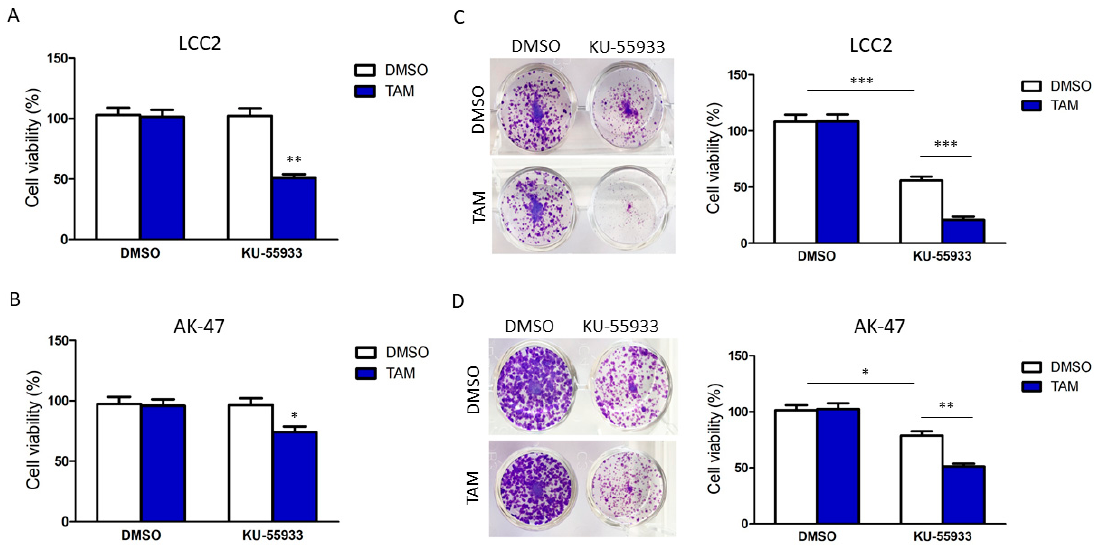
Figure 4. The effect of ATM inhibition by KU-55933 on TAM resistance and cell viability. The short- term effect of KU-55933 on TAM response in ( A ) LCC2 and ( B ) AK-47. The cells were treated with 5 nM of KU-55933 and 4 µ M of TAM for 96 h. Cell viability was determined by MTT assay. Student’s t -test was employed to compare the statistical significance between DMSO and TAM groups. The long-term effect of KU-55933 on TAM response in ( C ) LCC2 and ( D ) AK-47. The cells were treated with 5 nM of KU-55933 and 4 µ M of TAM for 14 days. A clonogenic assay was employed to determine cell viability. Results are shown as mean ± SD from six independent experiments. Student’s t -test was employed to compare the statistical significance between indicated groups: * p < 0.05, ** p < 0.01 and *** p < 0.001.